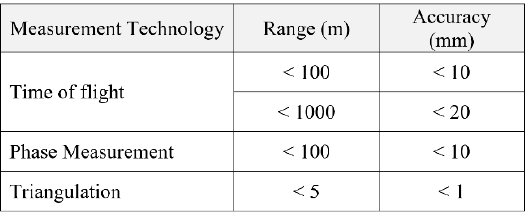
Table 1. Categories of laser scanner principle